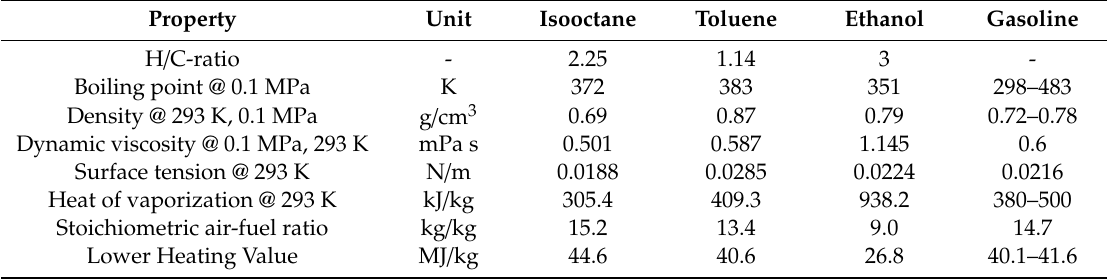
Table 1. Physical and chemical properties of the investigated fuels and gasoline for various ambient conditions. Data are extracted from references